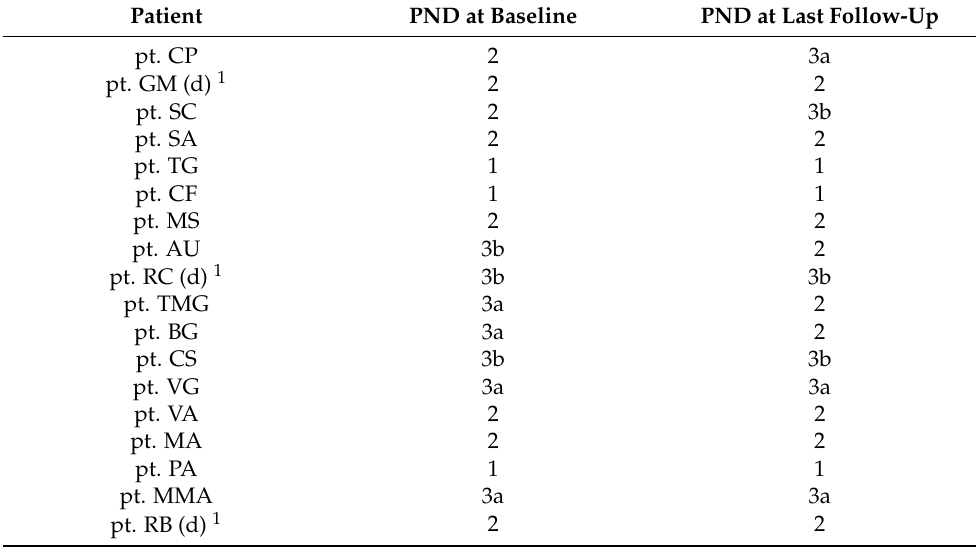
Table A1. PND score